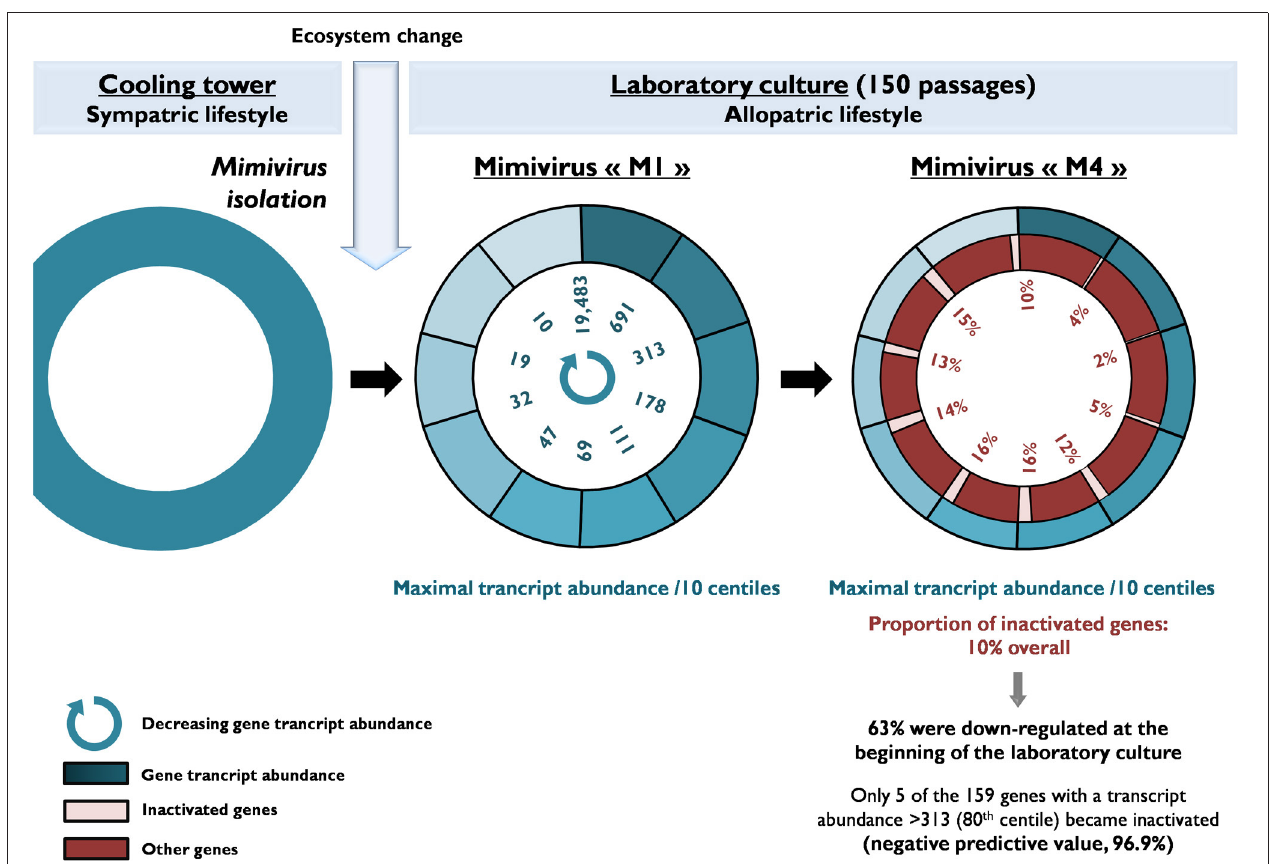
FIGURE 3 | A schematic diagram of the evolution of the gene content of Mimivirus during allopatric laboratory culture on amoebae. The diagram shows the transcript abundance for Mimivirus M1 genes and the proportions of inactivated genes after 150